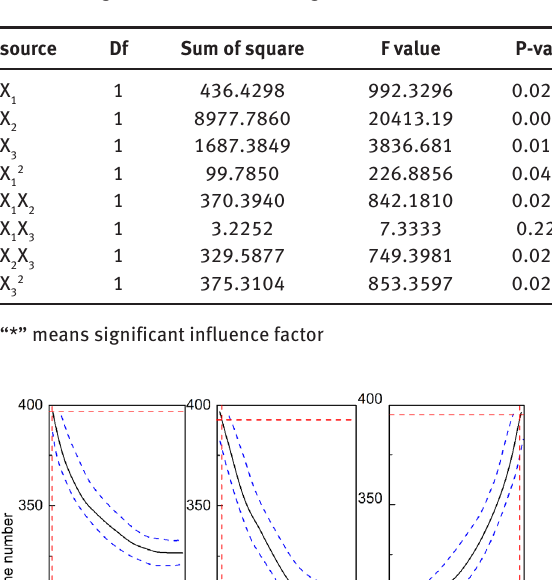
Table 7: Significance test for the regression coefficients.